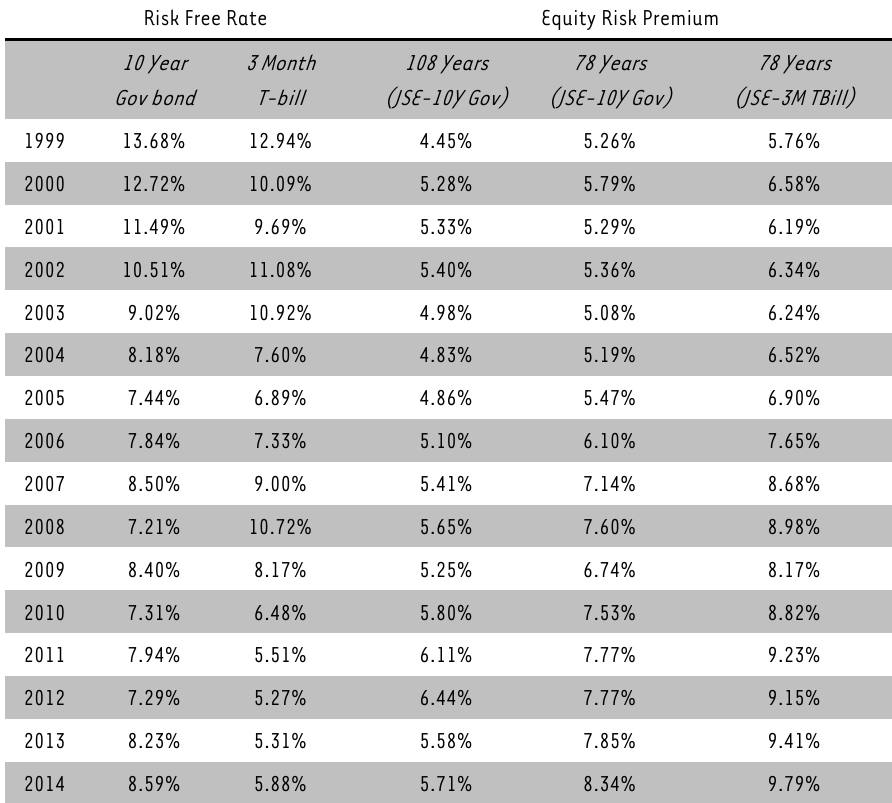
TABLE A-3: Risk free rates and Equity risk